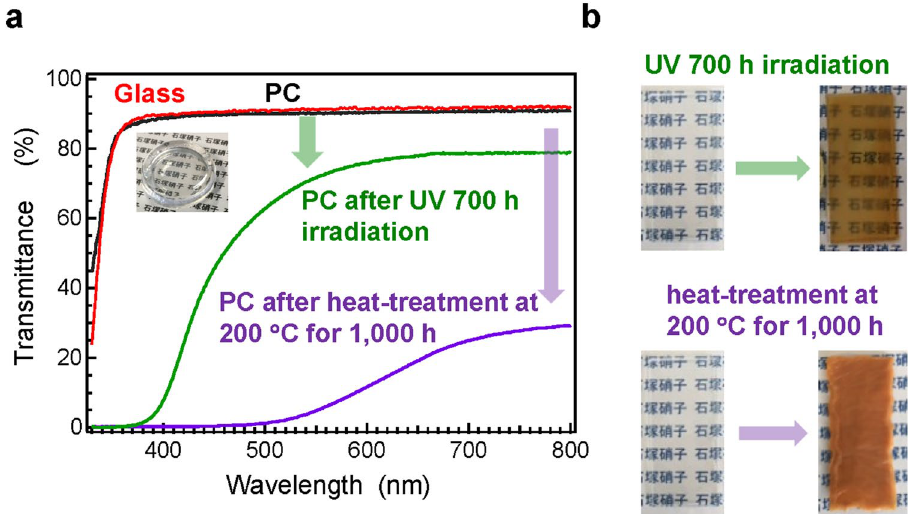
Figure 1. Transmittance of LKSP glass accelerated durability test by comparison with polycarbonates (PCs). ( a ) Transmittance spectra of LKSP glass and PCs after UV irradiation and heat treatment at 200 °C for 1000 h. ( b